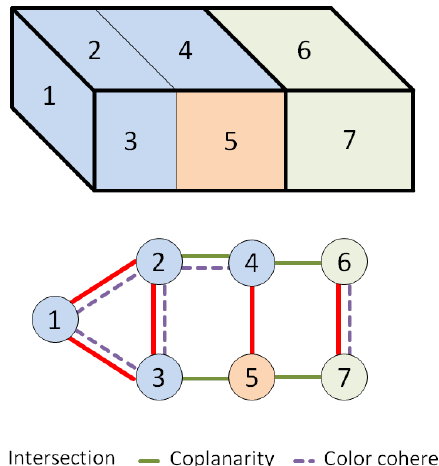
Figure 5: Coplanarity and color coherence are integrated in the neighbor relationship of an MRF and lead to an improved seg- mentation.